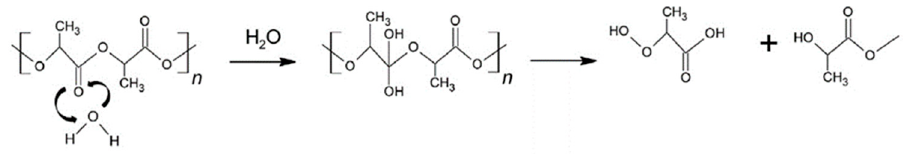
Figure 7. FTIR-ATR spectra of PLA/NR films: the region 3500–2800 cm − 1 ( a ) and the region 1800–1200 cm − 1 ( b ). The content of NR, wt.%: (1) 0; (2) 5; (3) 10; (4) 15. Black—initial samples, red—after hydrolytic degradation.